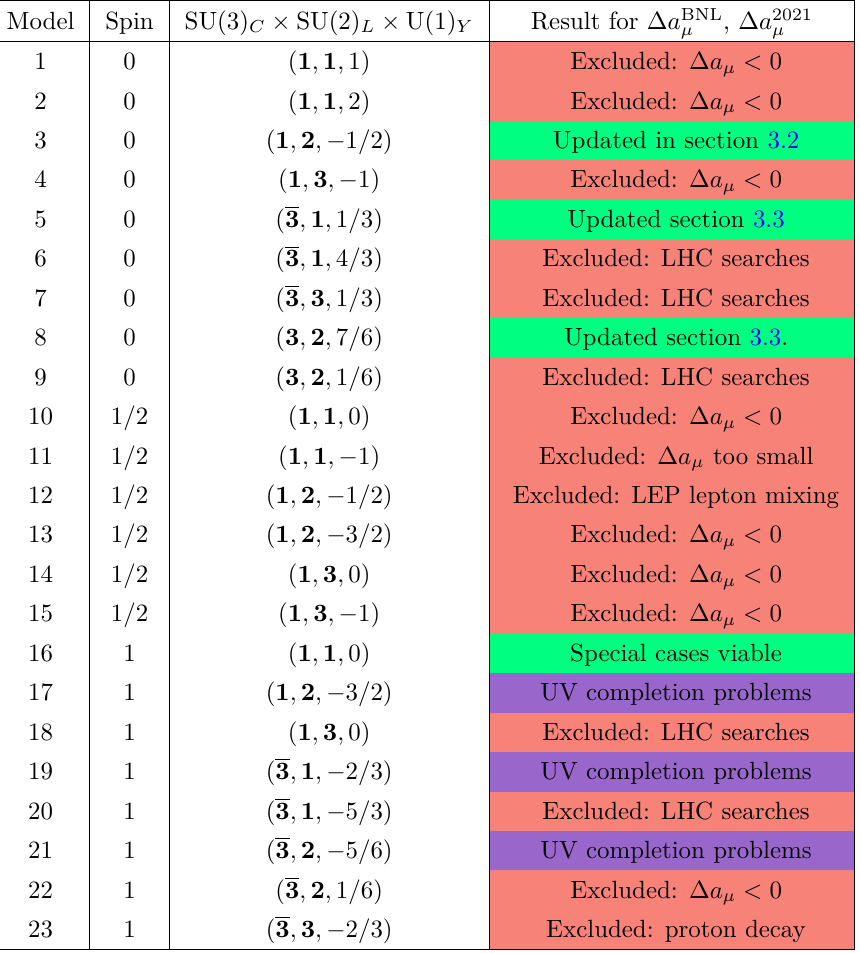
Table 1. Summary of known results for gauge invariant single field extensions with